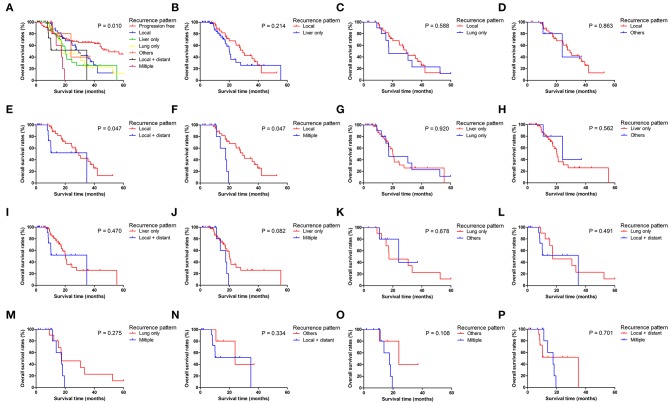
Pairwise comparison of overall survival for different tumor progression patterns. (A) Stratification of patients using different progression patterns of progression free, local, liver only, lung only, others, local and distant and multiple progressions. (B–P) Stratification of patients by comparing the following patterns of progression: local vs. liver only, local vs. lung only, local vs. others, local vs. local + distant, local vs. multiple, liver only vs. lung only, liver only vs. others, liver only vs. local + distant, liver only vs. multiple, lung only vs. others, lung only vs. local + distant, lung only vs. multiple, others vs. local + distant, others vs. multiple and local + distant vs. multiple.